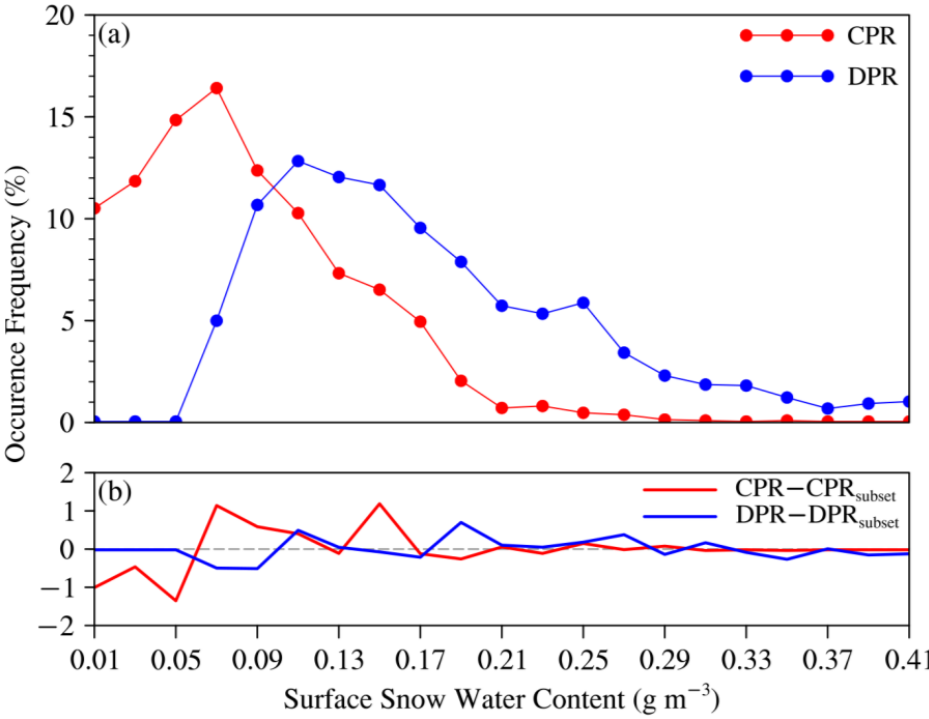
Figure 9. ( a ) Occurrence frequencies of CPR and DPR surface snow water contents as well as ( b ) differences in occurrence frequencies between DPR full scan and its central beams under the condition that both CPR and DPR detect the falling snow.